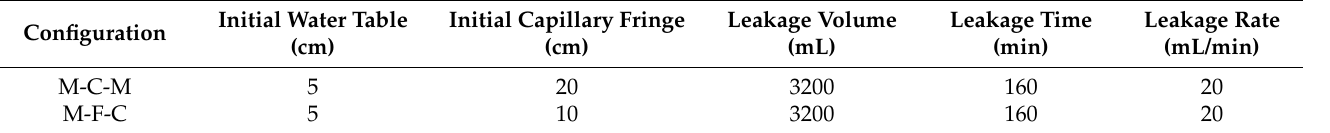
Table 4. Basic values of the experimental